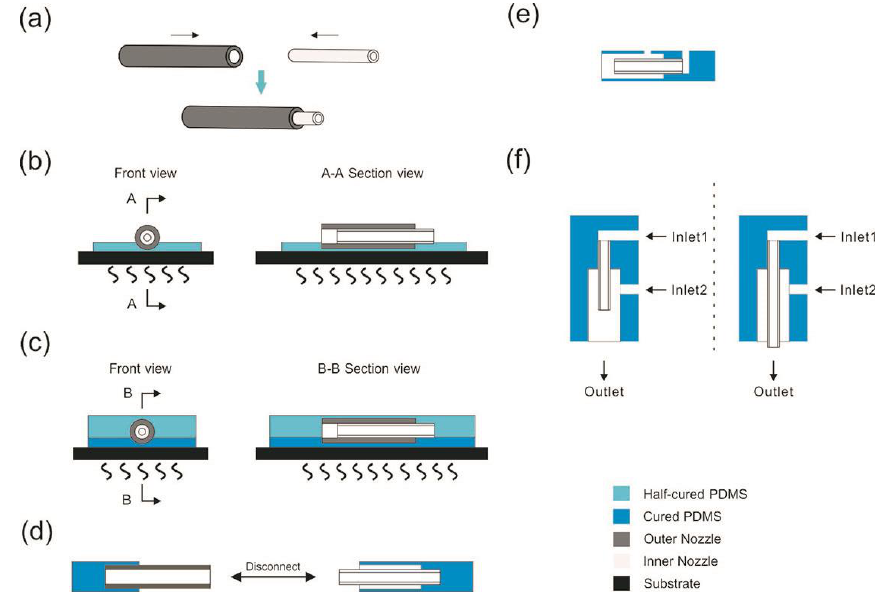
Figure 2. Fabrication of a coaxial nozzle. ( a ) Two steel tubes with different diameters were nested; ( b